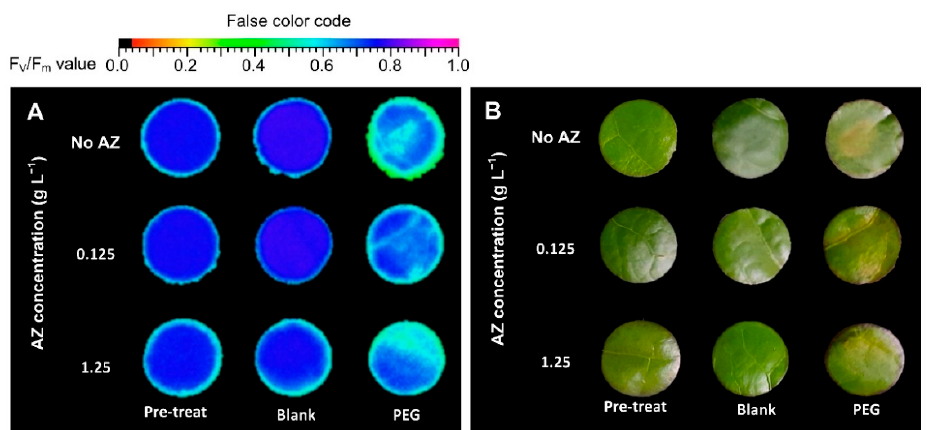
Figure 5. Chlorophyll fluorescence image ( A ) and leaf appearance correspond to F v /F m ( B ) value of tea leaf discs with pre-treatment (Pre-treat) of three different azoxystrobin (AZ) levels and then treated by blank solution (Blank) and PEG-induced osmotic stress (PEG), respectively.